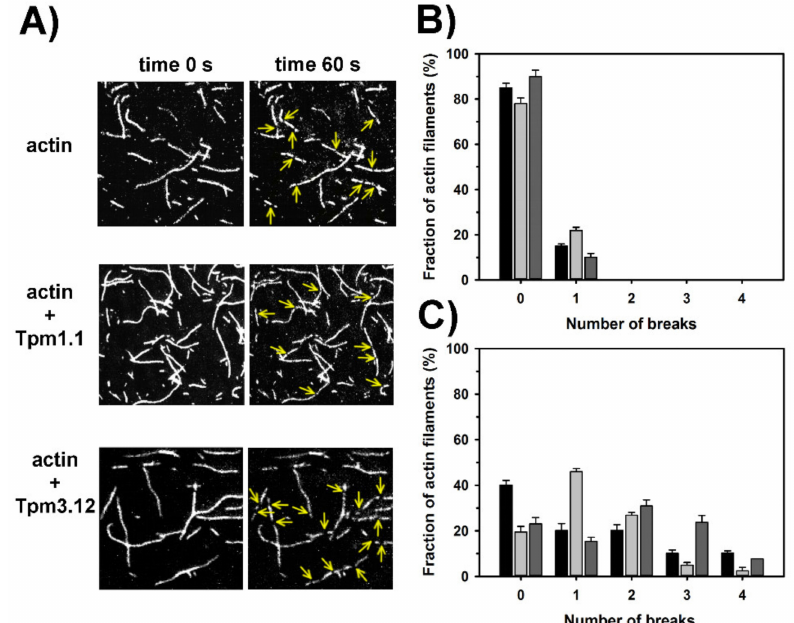
Figure 4. Regulation of severing activity of cofilin-2 by tropomyosin Tpm1.1 and Tpm3.12. ( A ) Snapshots of F-actin alone and F-actin in the presence of tropomyosin isoforms before (time 0 s) and after (60 s) addition of cofilin-2; selected breaks in the filaments are marked with yellow arrows. ( B ) Fraction of filaments with breaks in the absence of cofilin-2. ( C ) Fraction of filaments with breaks 60 s after addition of cofilin-2. The bars are color-coded as follows: F-actin alone (black), F-actin in the presence of Tpm1.1 (light grey), Tpm3.12 (dark grey). Bu ff er: 20 mM KCl, 2 mM MgCl 2 , 1 mM EGTA, 10 mM DTT, 10 mM Hepes, pH 7.5, supplemented with 0.1 mg / mL glucose oxidase, 0.01 mg / mL catalase, and 3 mg / mL glucose. The experimental errors were SE calculated in Excel (Microsoft O ffi ce Professional Plus 2013) from 100 filaments. Analysis of statistical significance of di ff erences